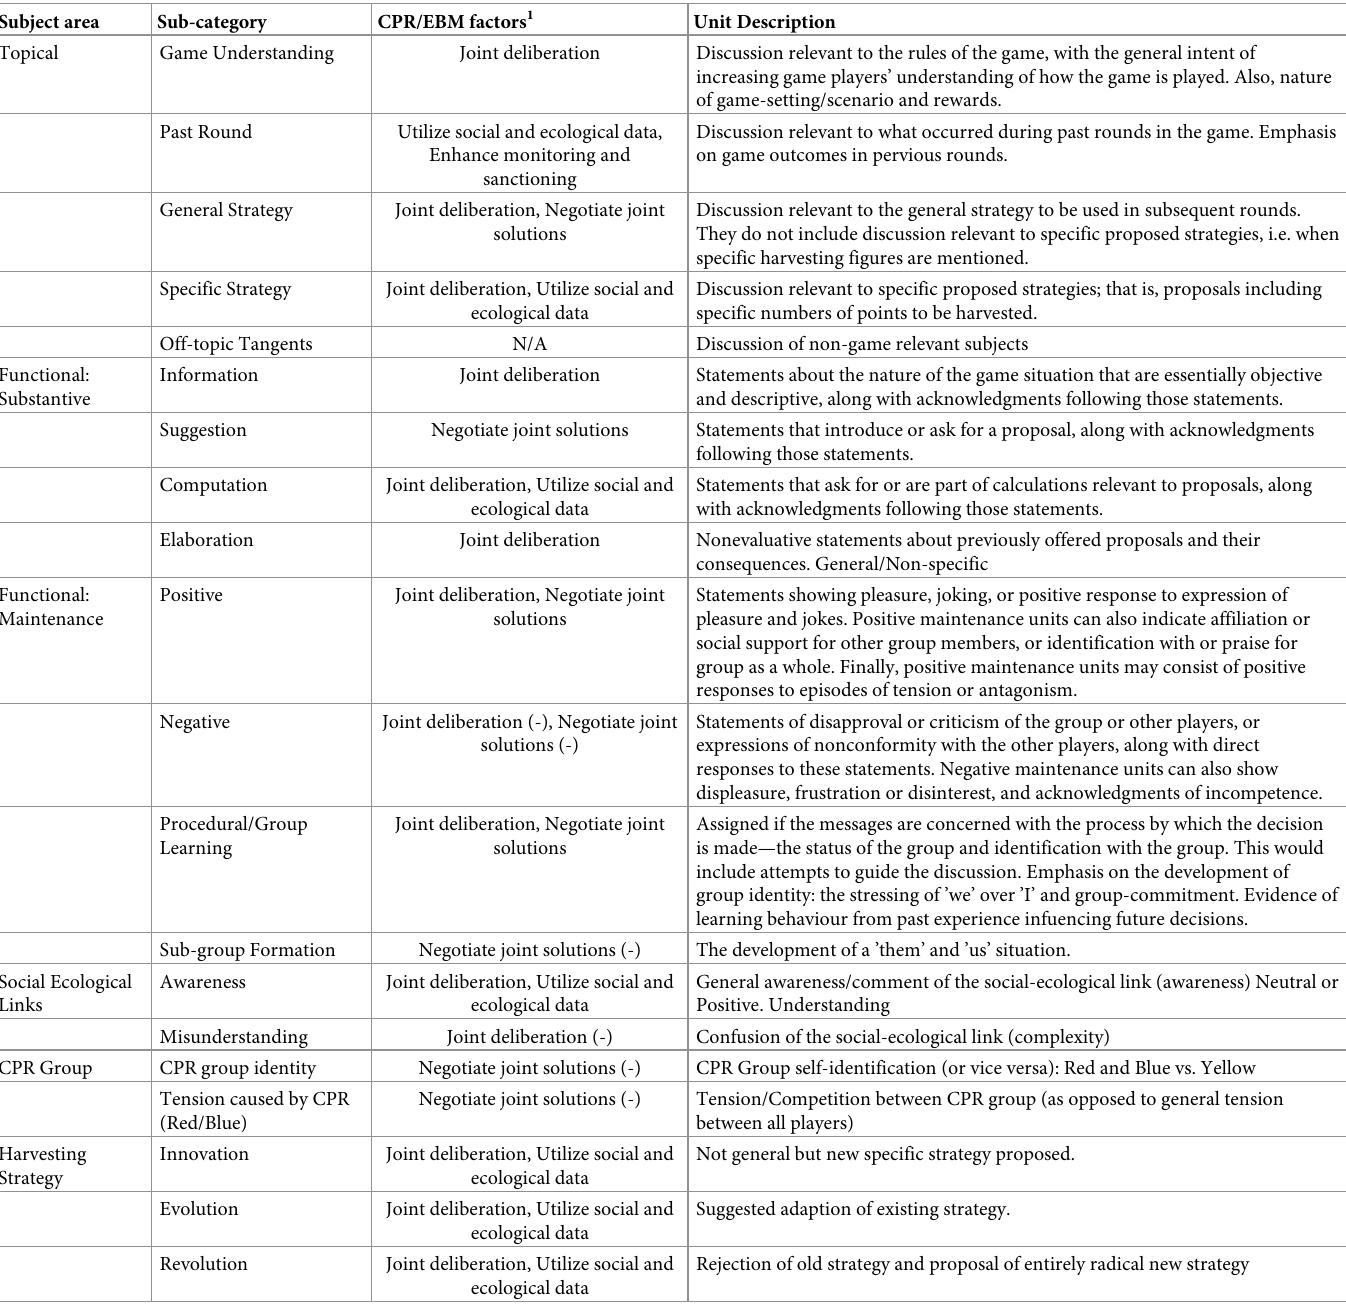
Table 1. Coding, CPR and EBM factors, and